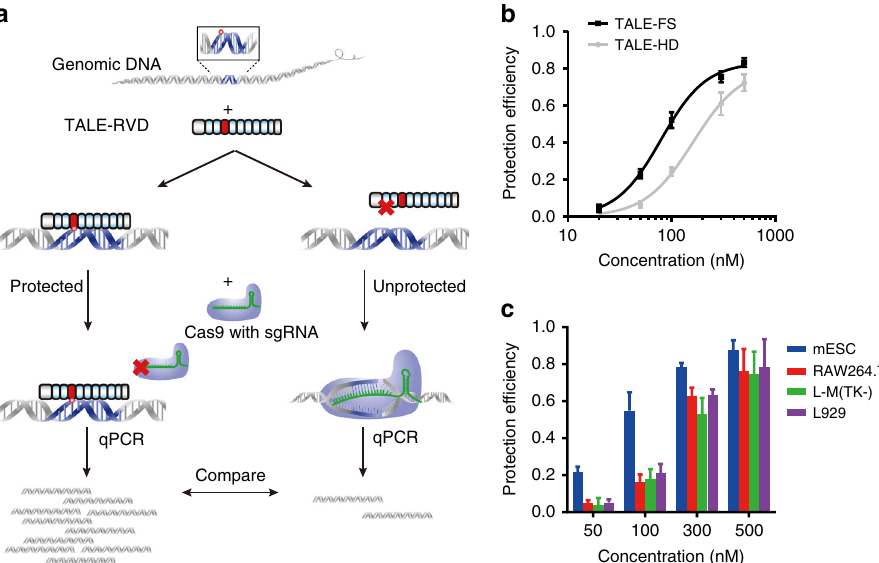
Fig. 5 Detection of 5hmC in genomic DNA at single-base resolution. a Work fl ow of base-resolution 5hmC detection by novel RVDs. Brie fl y, the targeted genomic region is protected by TALE, against Cas9-mediated DNA cleavage. b The protection ef fi ciency of TALE-FS ( black ) and TALE-HD ( gray ) targeting a single 5hmC site of mESC genome. c Protection ef fi ciency of TALE-FS for a single 5hmC site in the genomic DNA of mESC, RAW264.7, L-M(TK − ) and L929 cells. At this given site, mESC genome contains the highest 5hmC modi fi cation level among the cell lines. The data are means ± s.d., n = 3; * P < 0.05, and ** P < 0.005 two-tailed unpaired Student ’ s t